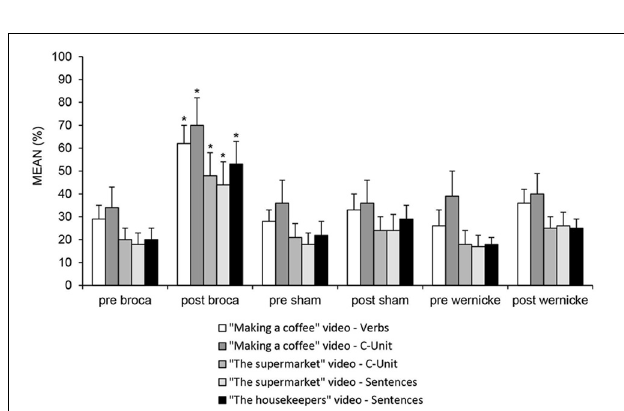
FIGURE 6 | Mean percentage of correct “C-Units”, verbs and sentences during the presentation of the three videos (“Making a coffee”, “The Supermarket” and “The Housekeepers”) presented only at baseline and at the end of treatment in the pre-and post-anodic Broca’s, sham and Wernicke’s conditions ( ∗ < 0.01),